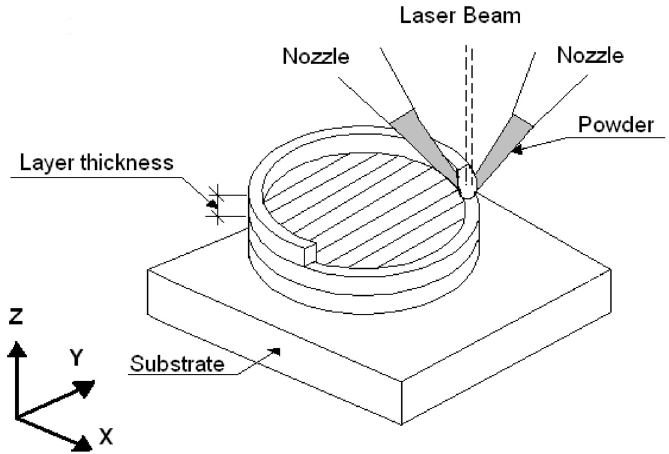
Figure 13. Schematic representation of the LENS process